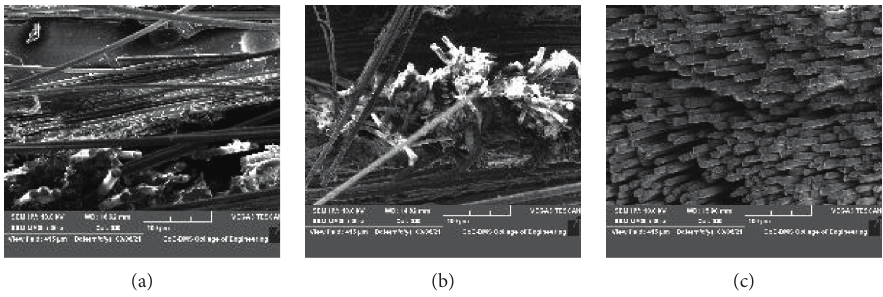
Figure 10: SEM images of tensile tested samples for (a) L 1 laminate; (b) L 2 laminate; (c) L 3